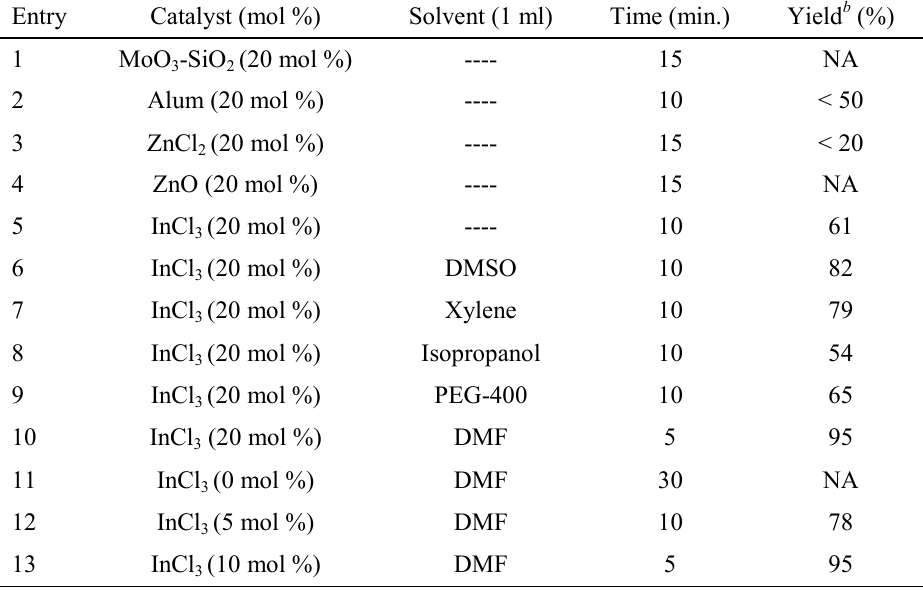
Table 1 . Screening of reaction parameters for the formation 5-phenyltetrazole